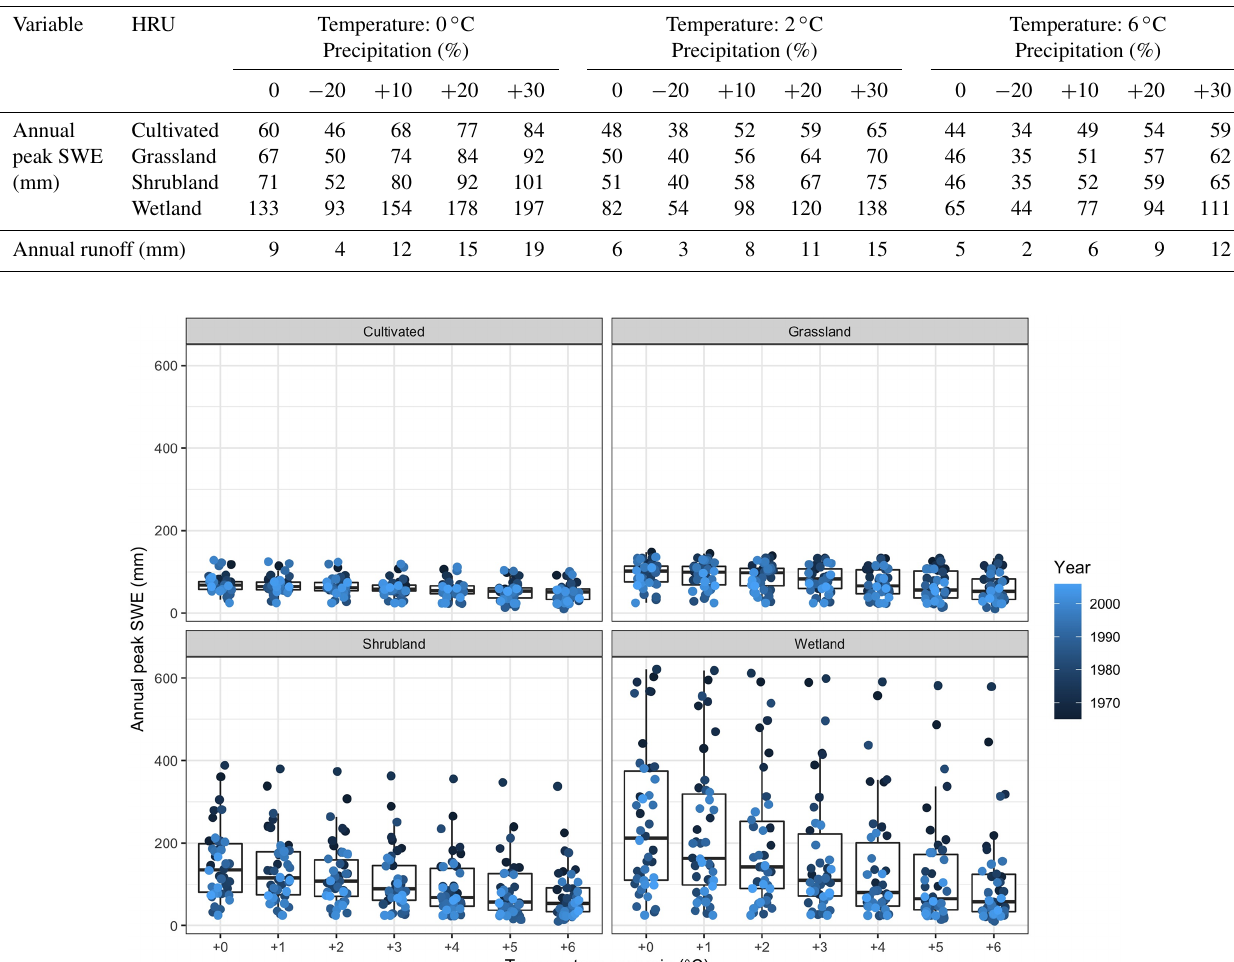
Figure 6. Peak virtual model-simulated annual snow accumulation (SWE) for cultivated, grassland, shrubland, and wetland HRUs for Medicine Hat climate under baseline conditions (1965–2006: 0 ◦ C) and warming of air temperature up to 6 ◦